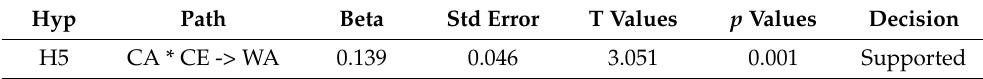
Table 12. Moderation Hypothesis